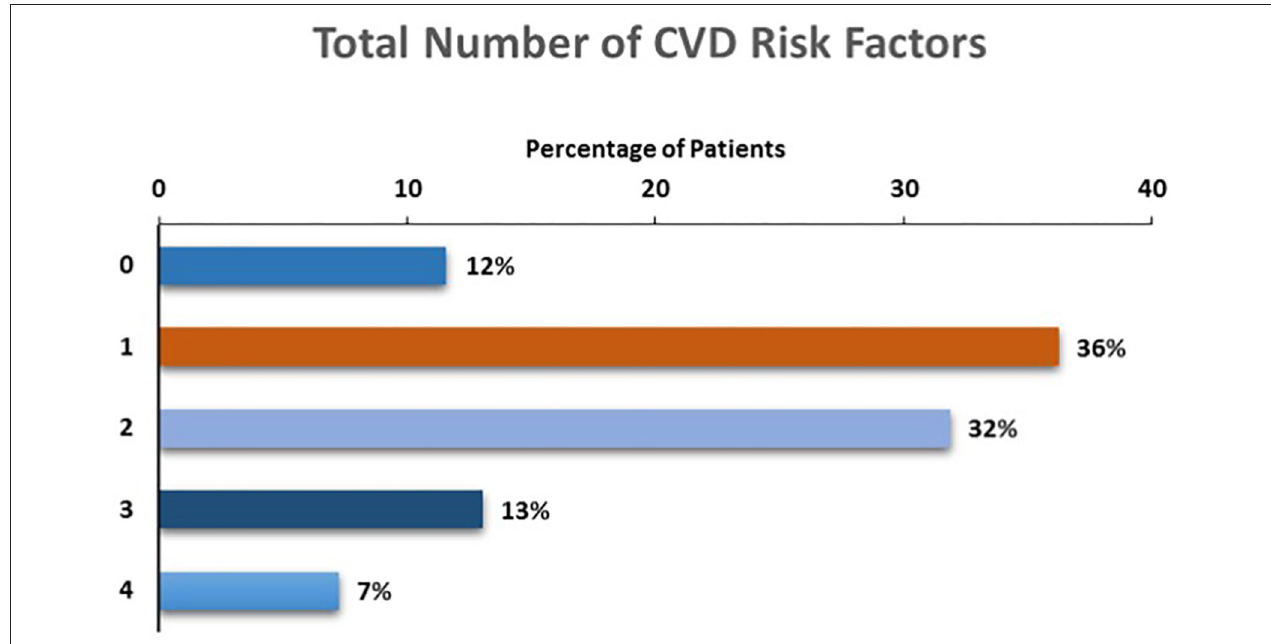
FIGURE 2 | Number of CVD risk factors among children and adolescents with MDD.